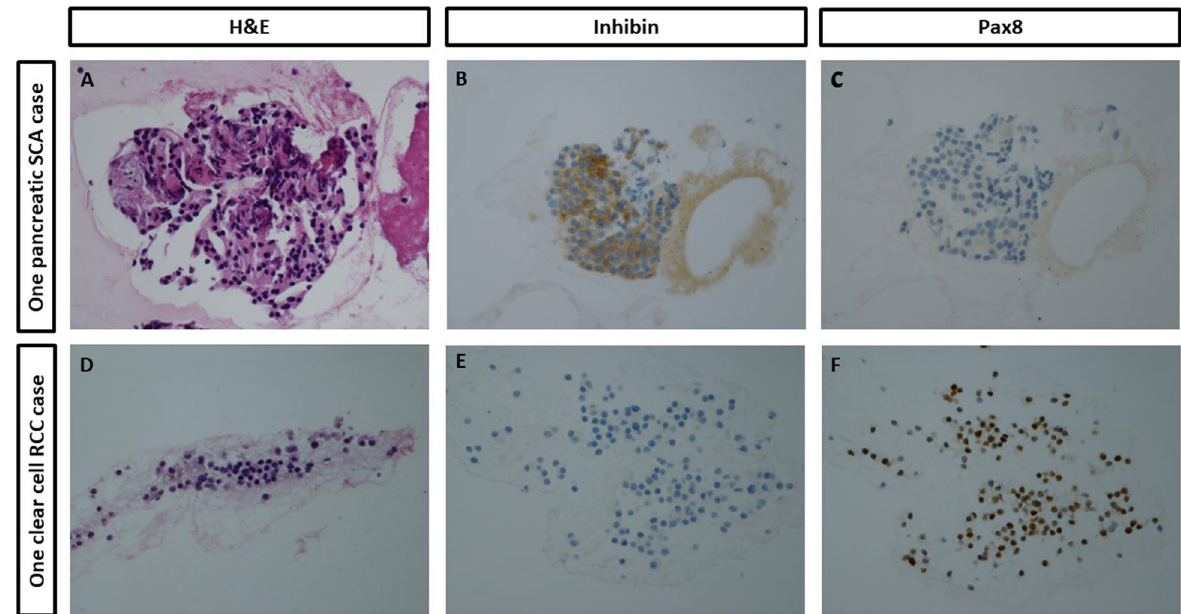
Fig. 2 Representative images from one pancreatic serous cystadenoma (SCA) cytology case and one cytology case of metastatic clear cell renal cell carcinoma (RCC) involving pancreas. A – C One pancreatic SCA cytology case. D – F One cytology case of metastatic clear cell RCC involving pancreas. A and D Hematoxylin and eosin (H&E) staining. B and E Inhibin. C and F Pax8. Magnification